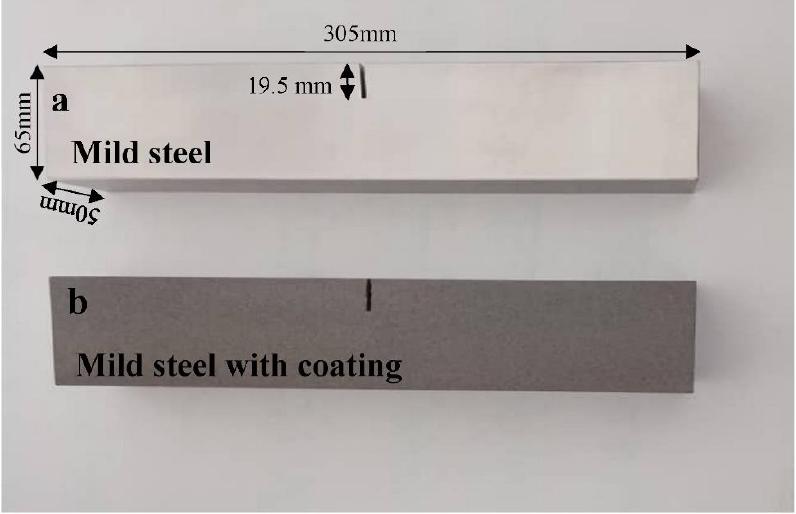
Figure 1. Single-edge-notch specimens ( a ) mild steel without coating ( b ) mild steel with coating.